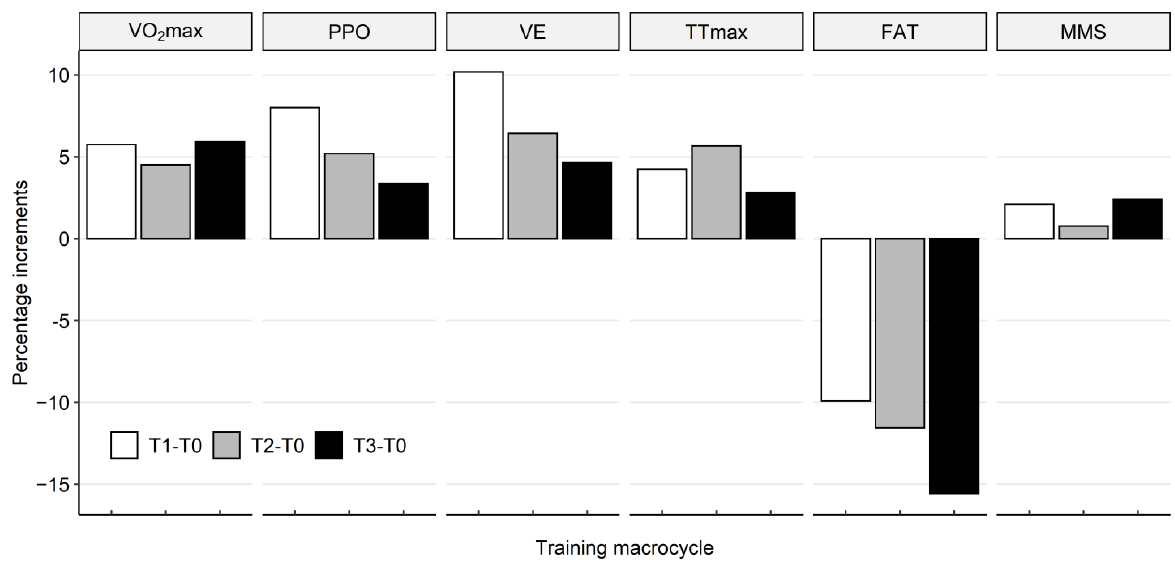
Figure 1. Percentage increases in the levels of physiological and somatic variables of cyclists in individual research periods (+/ − ∆ %), in the training macrocycle of cyclists with the base values T0: T1 − T0, T2 − T0 and T3 − T0. Abbreviations: VO 2 max—the maximal oxygen uptake; PPO—absolute value of maximum power; VE—ventilation; TTmax—maximum test duration; FAT—current body fat mass; MMS—skeletal muscle